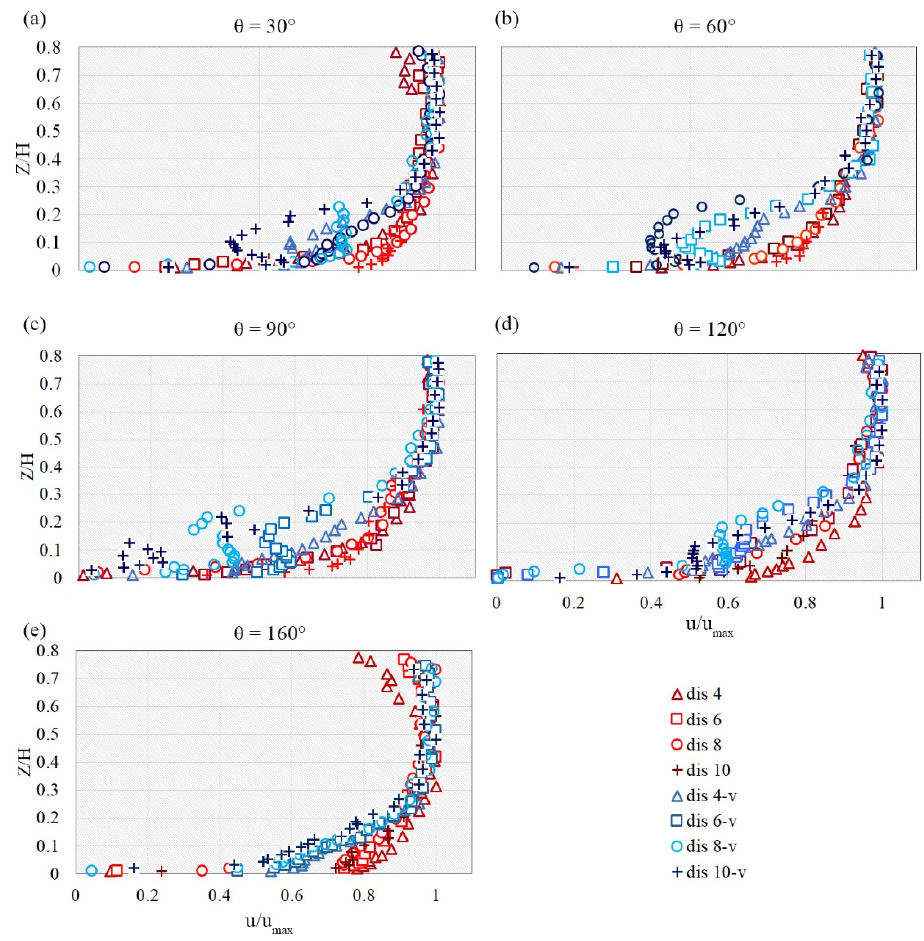
Figure 8. Profiles of the normalized tangential velocity u at different azimuthal planes, with specific distances from the abutment surface (4, 6, 8, and 10 cm) for the cases of un-vegetated bed (marked by red symbols) and vegetated bed (marked by blue symbols).